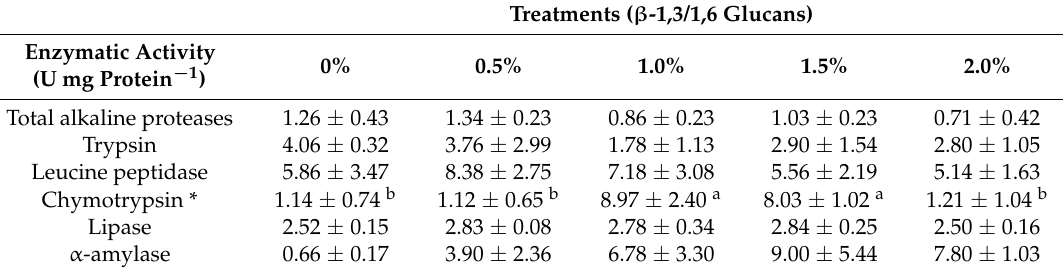
Table 2. Digestive enzymatic activity in A. tropicus fed formulated diets supplemented with β